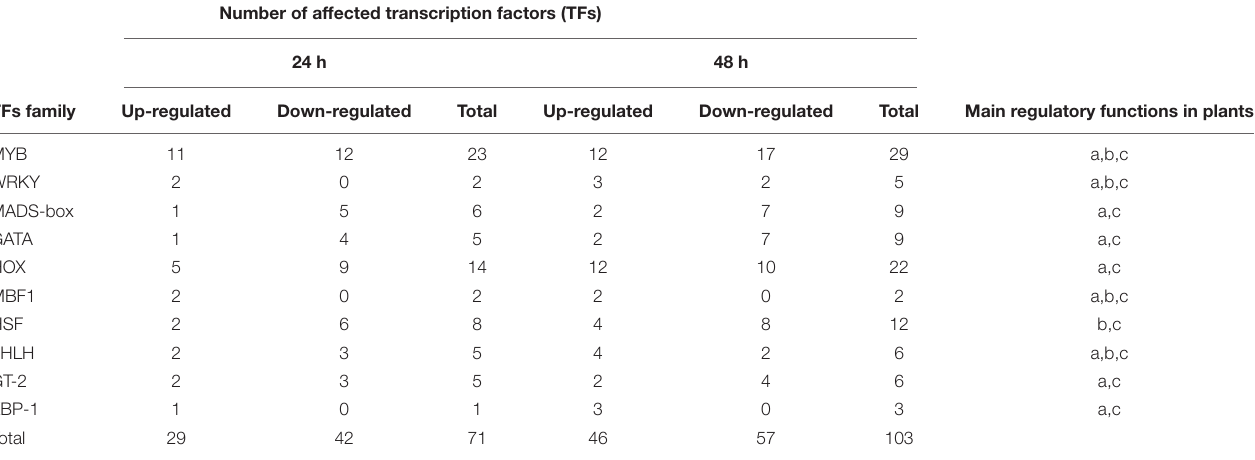
TABLE 3 | Plant transcription factors affected by crude toxins produced U. virens. Number of affected transcription factors